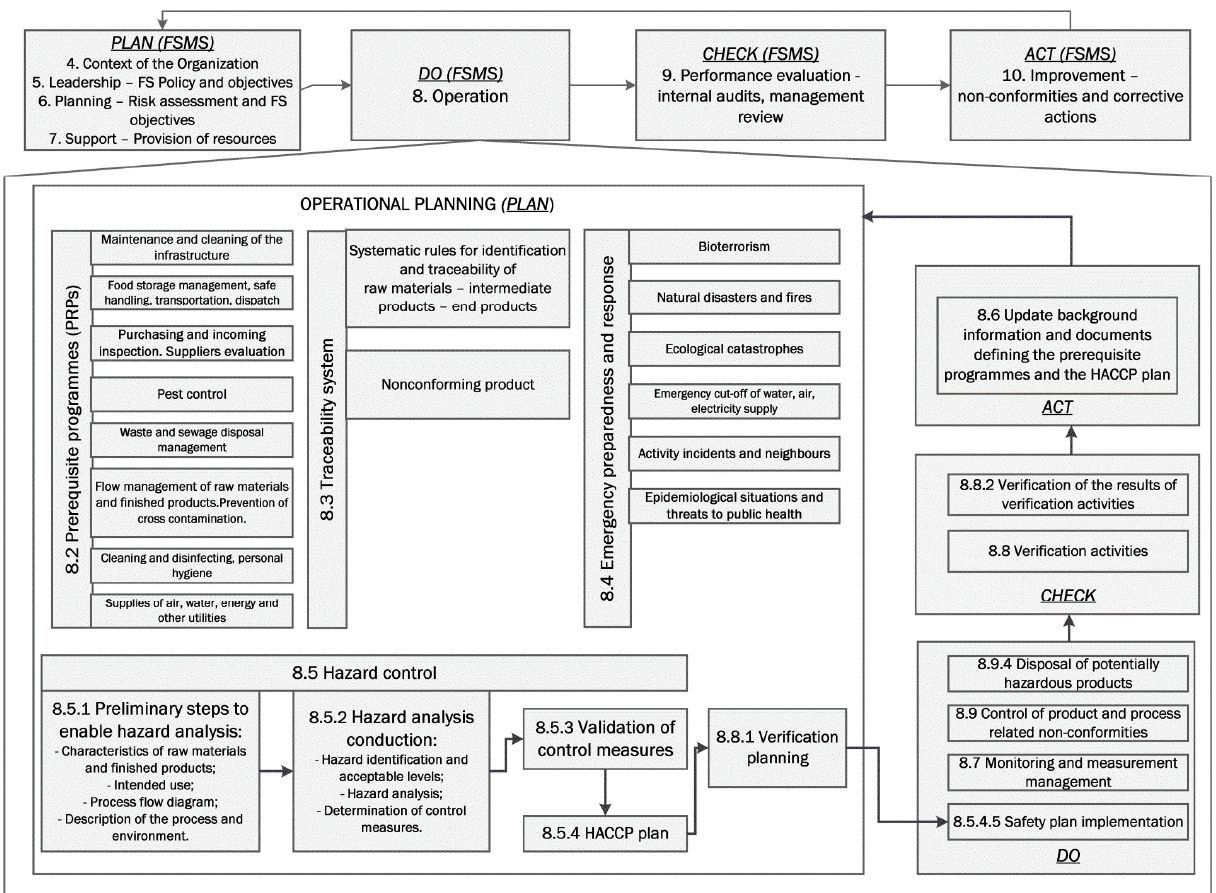
Figure 1. Model for building FSMS through the PDCA cycle (Source: authors).